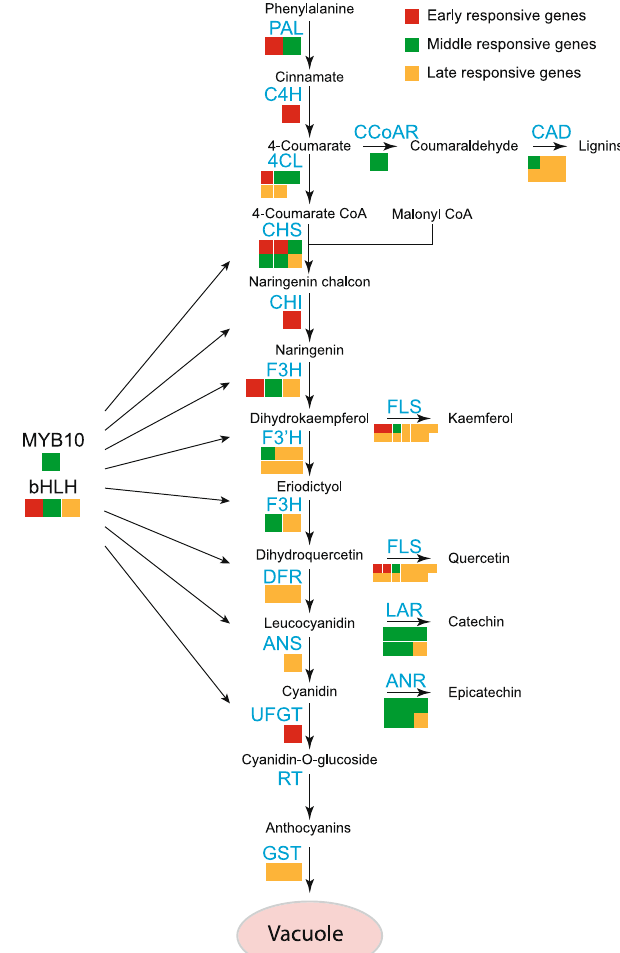
Figure 7. Categorisation of genes belonging to the phenylalanine pathway. Structural genes within the phenylalanine pathway were assigned to different light-responsive gene